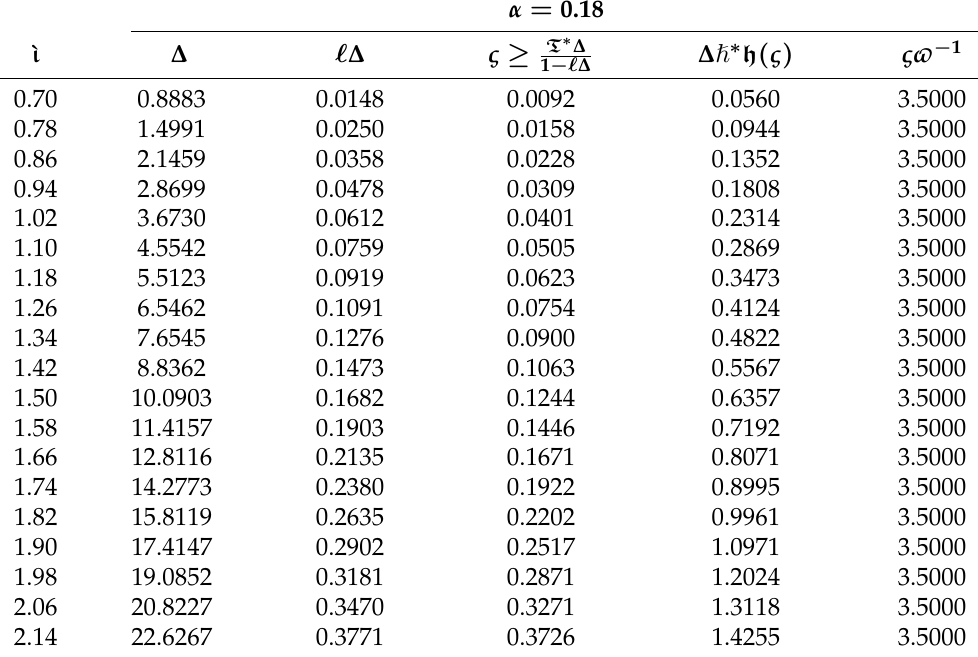
Table 4. Numerical values of ∆ , (cid:96) ∆ , ∆ (cid:125) ∗ h ( ς ) in Example 2 ∀ ` ι ∈ [ 0.7,2.1 ] when G = ` ι and α =